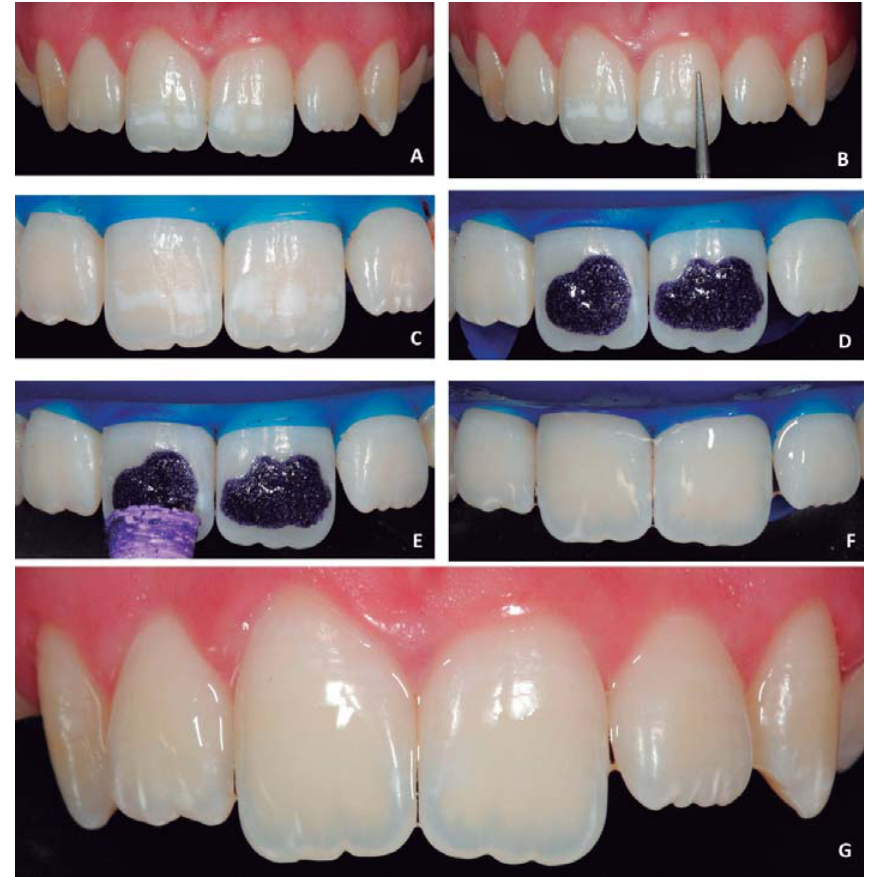
Figure 1- A: A teenage girl had idiopathic white enamel demineralization of her maxillary central incisors; B: After